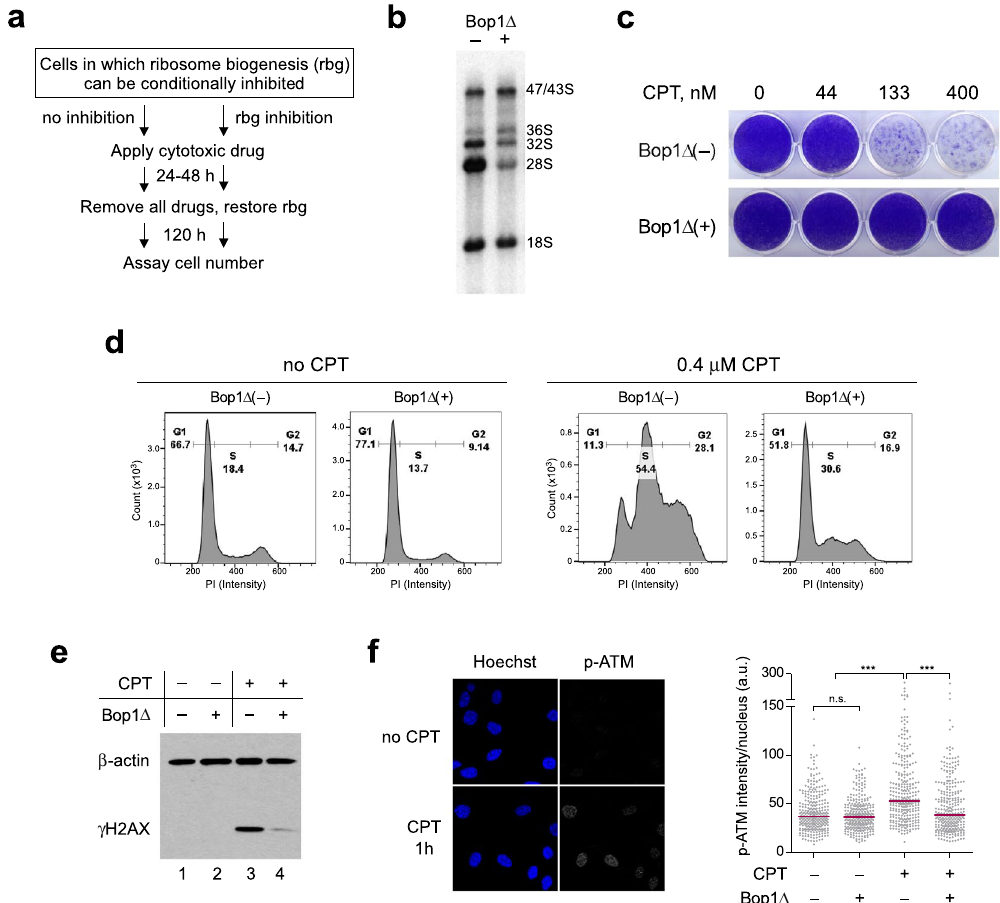
Figure 1. Expression of the dominant-negative Bop1 mutant, Bop1 Δ , confers protection against camptothecin (CPT). ( a ) Experimental protocol for testing cytoprotective effects of the inhibition of ribosome biogenesis. ( b ) 32 P labeling of rRNA shows reduced levels of the newly synthesized 28S rRNA and altered levels of 36S, 32S pre- rRNAs in D411 cells after induction of Bop1 Δ for 24 h ( + ) as compared to uninduced cells (–). ( c ) Expression of Bop1 Δ in D411 cells was either induced ( + ) for 24 h with 1 mM IPTG or not induced (–), and equal numbers of cells were then treated for 24 h with the indicated concentrations of CPT. Cells were stained with crystal violet 5 days after treatment. No IPTG was present in medium during the recovery period. ( d ) Representative DNA profiles of D411 cells that were untreated or treated with 0.4 μ M CPT for 24 h. Prior to drug treatment, cells were either incubated or not with IPTG for 24 h to induce Bop1 Δ . Following drug treatment, cells were harvested, permeabilized and their cell cycle profiles determined by staining with propidium iodide (PI). ( e ) Bop1 Δ expression attenuates γ H2AX levels induced by CPT. D411 cells were either incubated or not with IPTG for 24 h and exposed to 0.4 μ M CPT for 1 h. γ H2AX and β -actin (loading control) were detected by immunoblotting. The experiment was repeated four times with similar results. The original immunoblot images are shown in Supplementary Figure S7. (f) Representative images illustrating increased ATM phosphorylation in the nuclei of cells treated with 0.4 μ M CPT for 1 h. Immunofluorescence analysis was done with p-ATM(Ser1981) monoclonal antibodies. Quantification of the antibody signal shows its significant reduction in Bop1 Δ - expressing cells ( n = 300 nuclei per group; *** P < 0.0001, Student’s two-tailed t -test; horizontal line denotes the